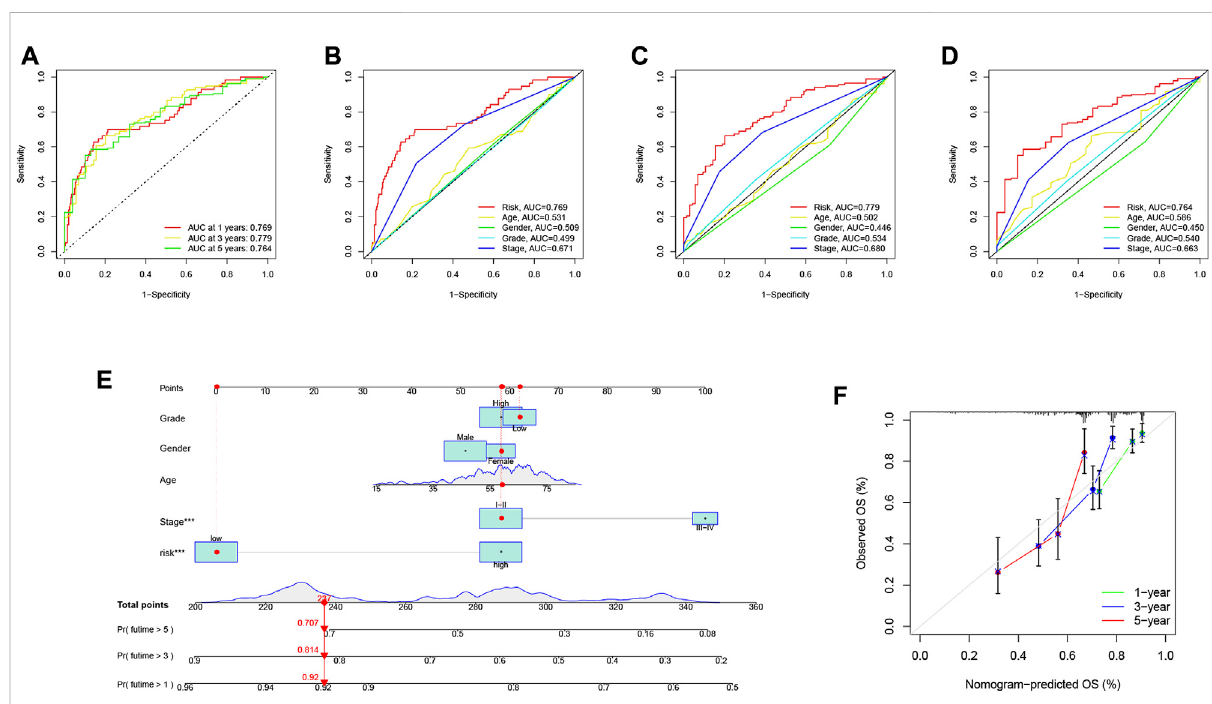
FIGURE 8 Validation of prognostic ef fi ciency of risk signatures. (A) ROC analysis was used to estimate the predictive value of prognostic features. (B – D) Theareaunderthecurve(AUC)oftheriskscoreforpredictingoverallsurvivalat1,3,and5 yearsandotherclinicalcharacteristics. (E) Nomogramwas used to predict survival in HCC patients. (F) 1-, 3-, and 5-year nomogram calibration